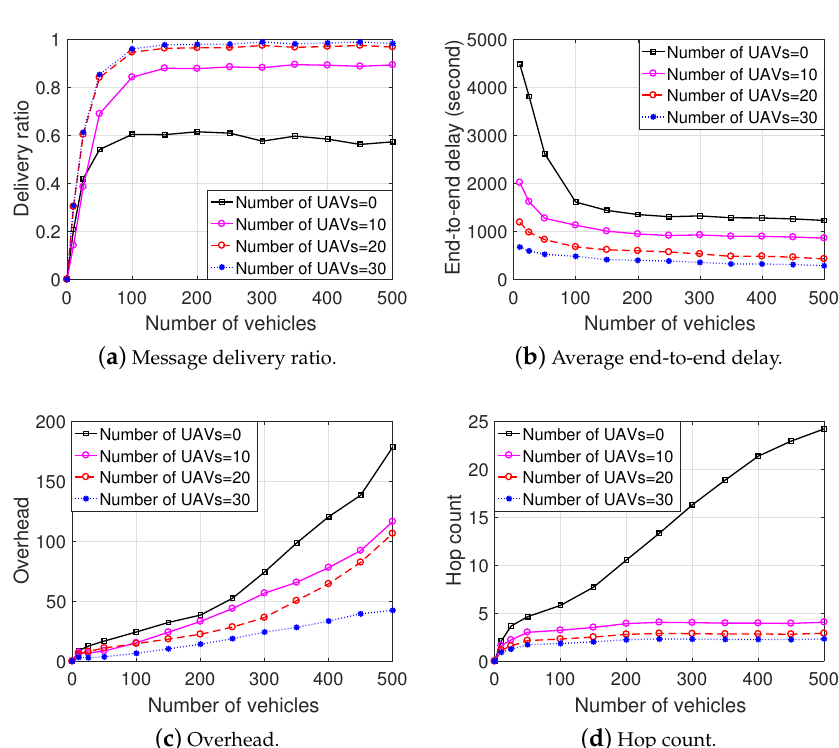
Figure 5. Network performance vs. number of